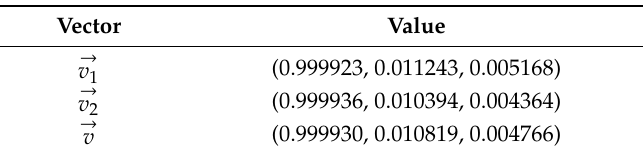
Table 6. The calculation results of the extension vector.